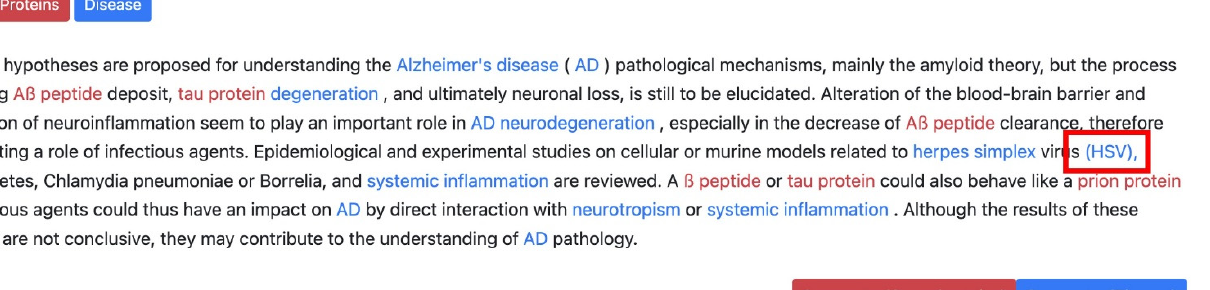
Figure 9. User-defined NE annotation information added to the information. Red box highlights terms that the user has manually annotated.